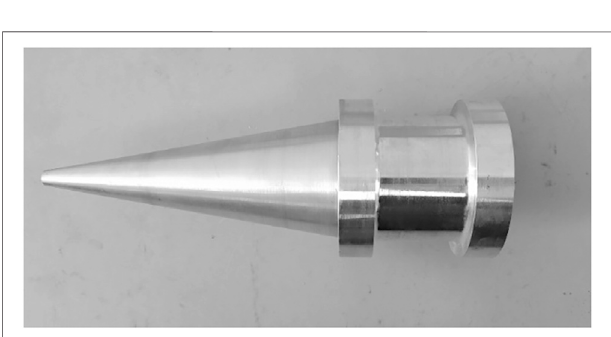
FIGURE 7 | Photograph of an assembled experimental piece.